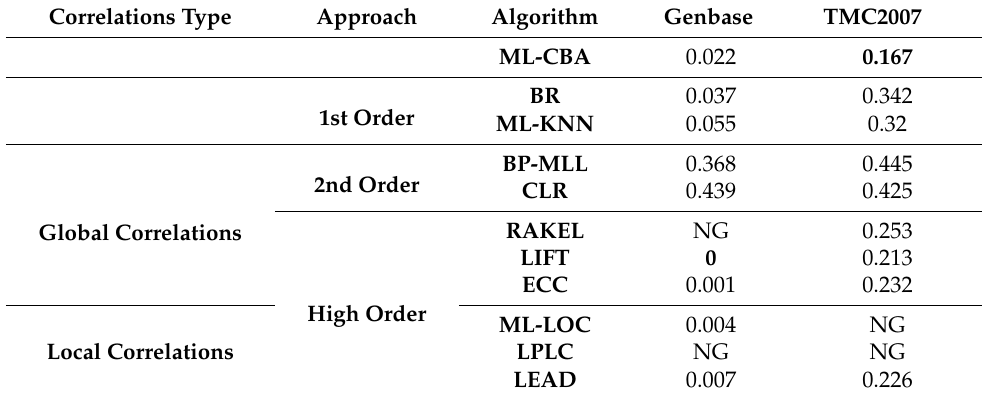
Table 9. The one-error results of the proposed ML-CBA algorithm on the large-sized datasets with respect to several MLC